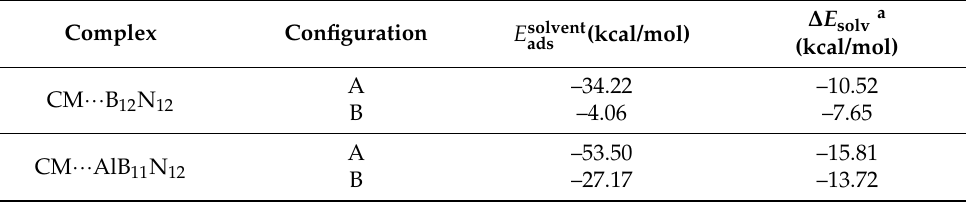
Table 5. Adsorption ( E solvent ) and solvation ( ∆ E solv ) energies for the CM ··· B 12 N 12 and ··· AlB 11 N 12 optimized complexes in the water phase. All energies are calculated in kcal/mol.